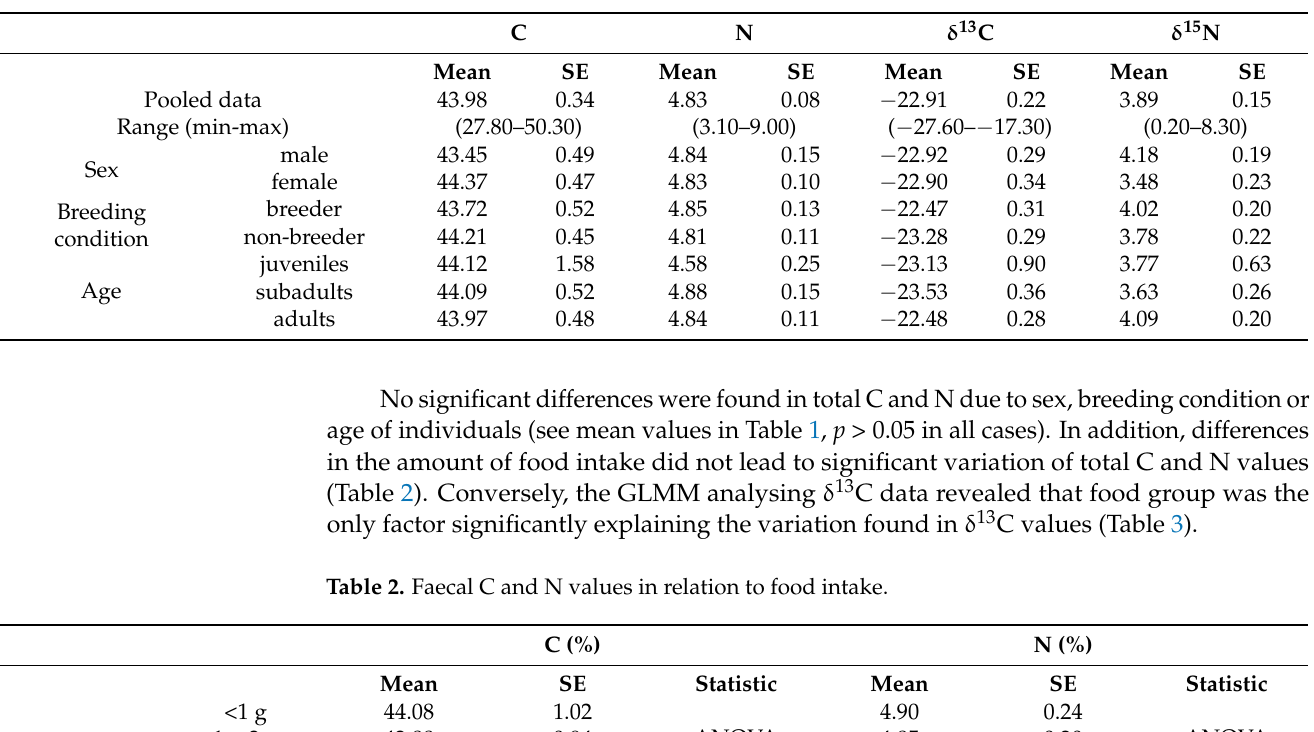
Table 1. Elemental (C and N in %) and isotopic ( δ 13 C and δ 15 N in ‰) values obtained in wood mouse faecal samples.